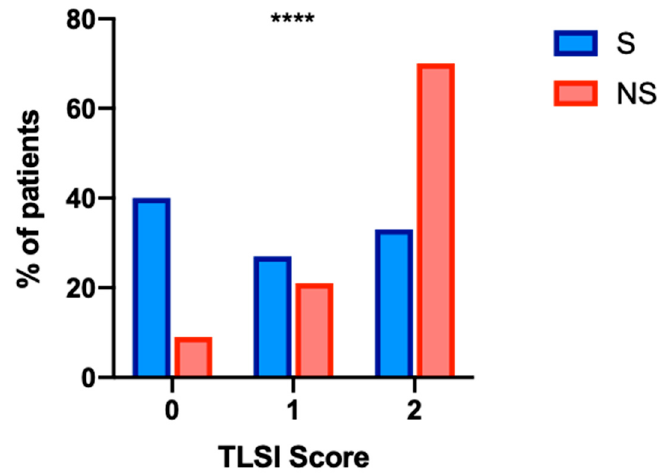
Figure 1. Thirty-day mortality rates (%) in COVID-19 patients according to TLSI score. Survivors (S) are represented in blue, and non-survivors (NS) are represented in red. The analysis was performed with the Chi 2 test. The Chi 2 test for trend was also used, showing a statistically significant trend for increasing 30-day mortality rates proceeding from TLSI = 0 to TLSI = 2, p < 0.0001. TLSI: T- Lymphocyte subset index; ****: p < 0.0001.